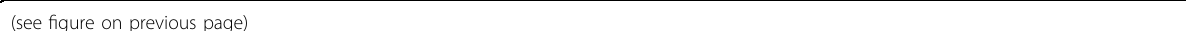
Fig. 1 Melatonin treatment decreases AGE-induced apoptosis in EPCs. a Cell Counting Kit-8 results of EPCs treated with BSA and different concentrations of AGEs for 24 h. b – c , g Immuno fl uorescence and Western blot analysis of the protein expression levels of cleaved caspase-3 in treated EPCs. Scale bar, 25 μ m. d Cell Counting Kit-8 results of EPCs treated with different concentrations of melatonin for 24 h. e Cell Counting Kit-8 results of melatonin-pre-treated EPCs induced by AGEs. f , h Protein content of cleaved caspase-3 in EPCs treated with AGEs and melatonin. i , j Apoptosis was detected using the annexin V-FITC/PI kit. Typical images of apoptosis of different groups are shown, as measured by the CytExpert software. Data are presented as the mean ± SEM. Signi fi cant differences between the treatment and control groups are indicated as ** P < 0.01 or * P < 0.05. n =